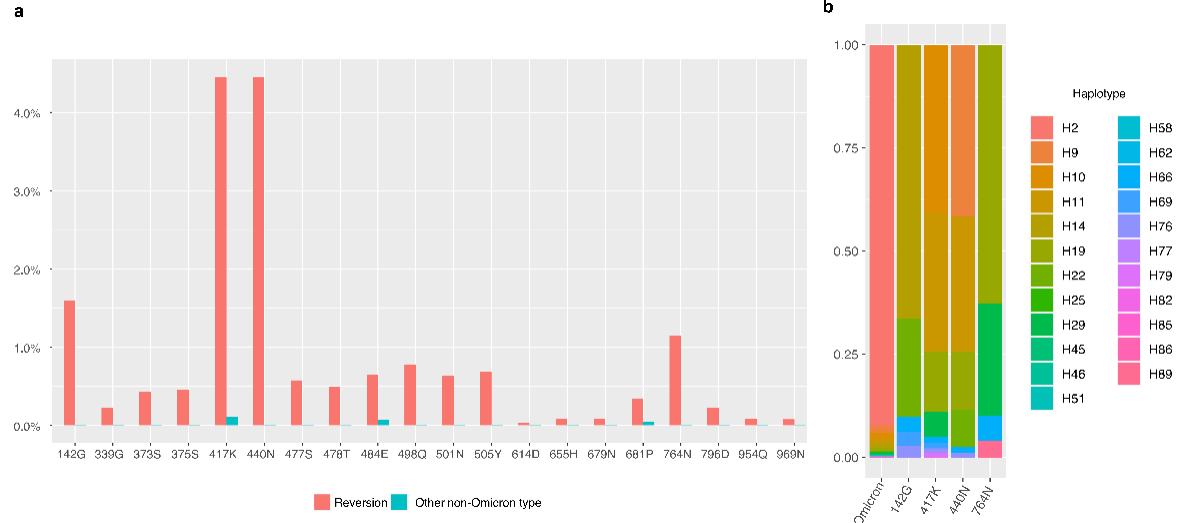
Figure 5. The proportion of reversions at the core sites of Omicron. ( a ) Revision of each core site of Omicron. Orange bars are the proportions of reversion in each core site. Blue bars are the proportions of the other non-Omicron-type mutations in each core site. ( b ), Intact-Omicron and post-Omicron haplotypes and their proportion on 142G, 417K, 440N, and 764N. Colors indicate different haplotypes.